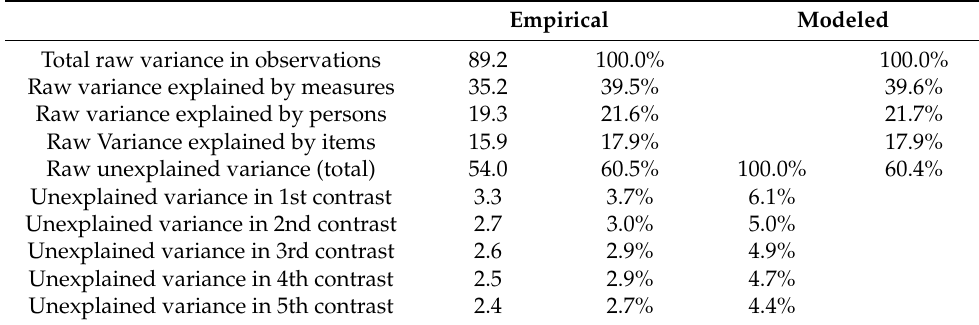
Table 4. Principal component analysis of residuals (in Eigenvalue unit). Empirical Modeled Total raw variance in